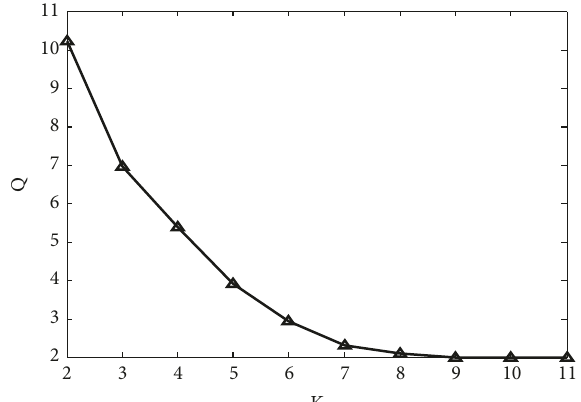
Figure 5: Trend of controllability of WS small-world network with 𝐾 varying across 2,2, .. ., 11 .